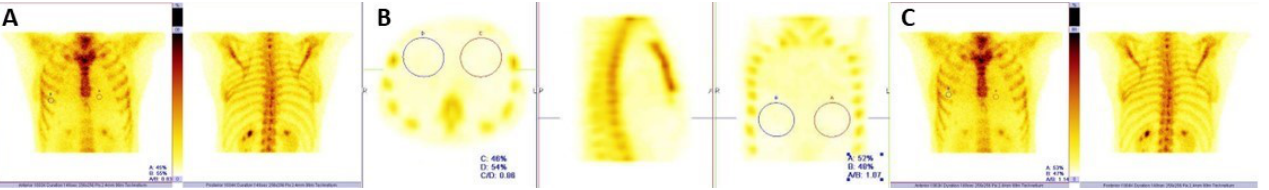
Figure 5. 66 year old male patient whose visual score was 0 on the bone scan, H/Rib = 0.83 (image ( A )), H/Cl region = 0.86 and 1.07 on SPECT images (image ( B )) followed by 1.14 on static images (image ( C )); soft tissue biopsy showed the presence of amyloid and FLC dosage determined the presence of kappa lambda chain; eGFR value (calculated by the MDRD and Cockcroft–Gault for- mula) determined stage 2 kidney disease. Images obtained from the archives of the Nuclear Medi-